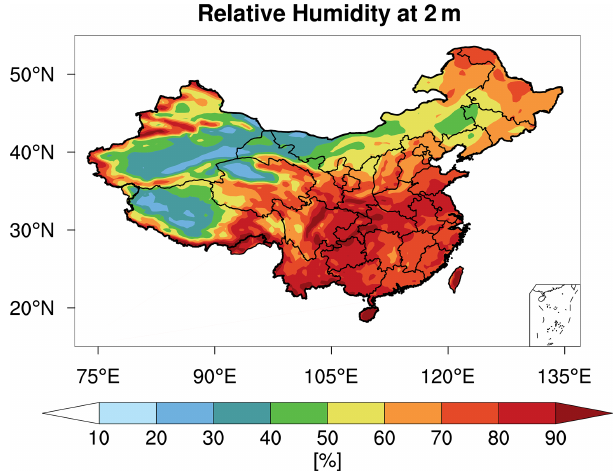
Figure 6. Spatial distribution of mean 2m relative humidity [%] from WRF-Chem during the study period of 15 October–2 Novem- ber